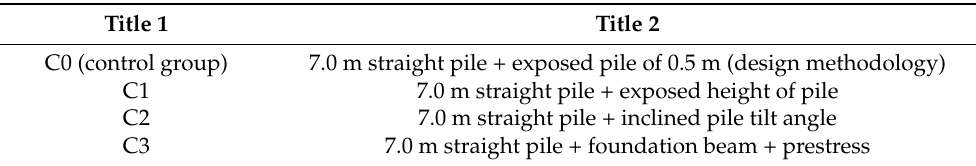
Table 1. Foundation displacement-control